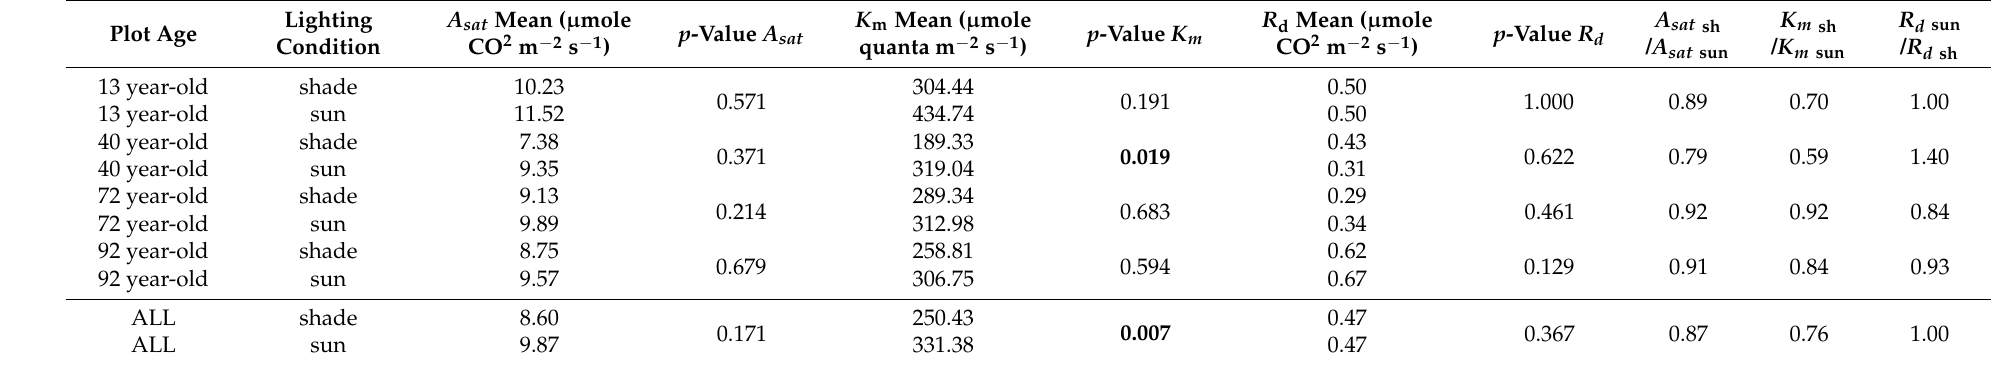
Table A4. Photosynthetic parameters of the Michaelis–Menten light response curve for sun and shade leaves in each study plot. Differences in mean values of A sat and K m were tested with a t test, with bold, ( p < 0.05) indicating statistical significance. A sat saturated net photosynthetic rate ( µ mole m − 2 s − 1 ), K m half saturation coefficient ( µ mole quanta m − 2 s − 1 ) and R d , dark respiration rate ( µ mole m − 2 s − 1